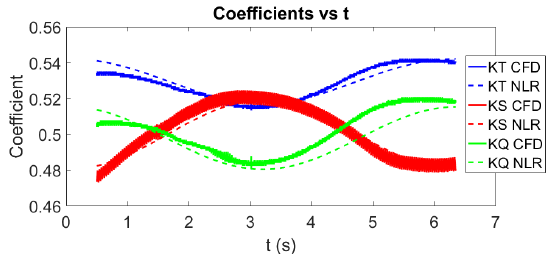
Figure 17. Behind condition Test 1 coefficients as a function of time predicted by nonlinear regression.